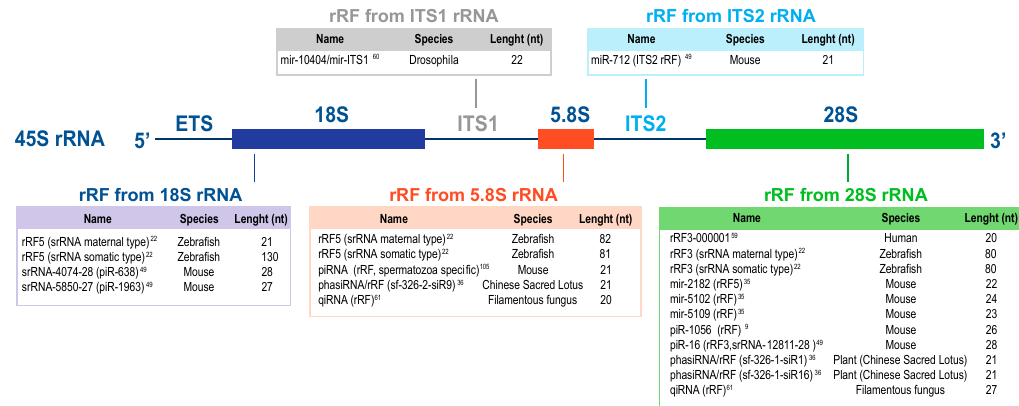
Figure 2. List of the major rRFs reported in the literature. The rRFs have been classified beyond the provenance from the 18S, 5.8S, 28S, ITS1, or ITS2 rRNA. For each rRF, the name, species of origin, and length are specified. An rRF described in a species may not be conserved in other species. Each organism has different levels of regulation and organization, and, although similarities exist between organisms, the occurrence and sequence of rRFs in a given rRNA region may be different. For example, ITS1 contains MER45C, which may be specific to vertebrates. Yet, in Drosophila a microRNA is shown in that region.